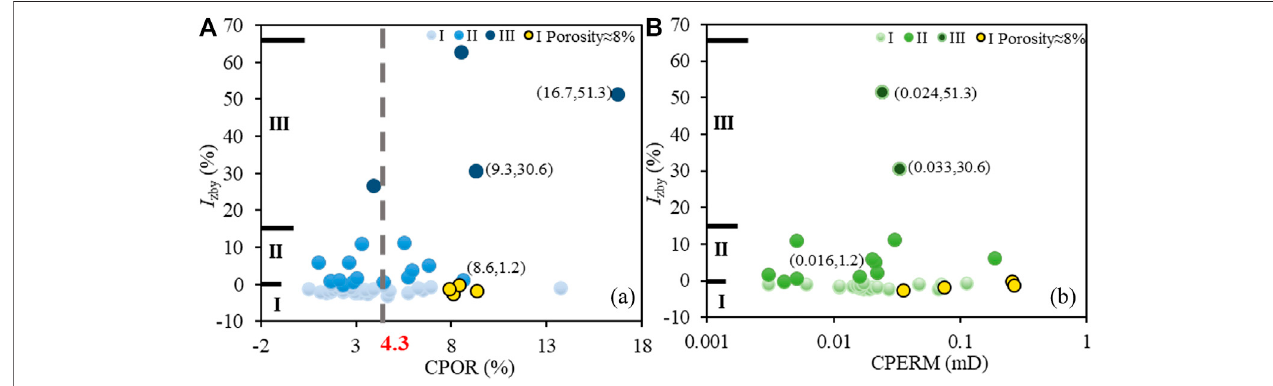
FIGURE 6| Correlation between physical propertiesand the alteration degree I zby . (A) Core porosity (CPOR) and I zby ; (B) Core permeability (CPERM) and I zby . The different colored dots represent the class I, II, and III altered rocks, in which the yellow dots stand for the class I altered rocks with the porosity of 8%.